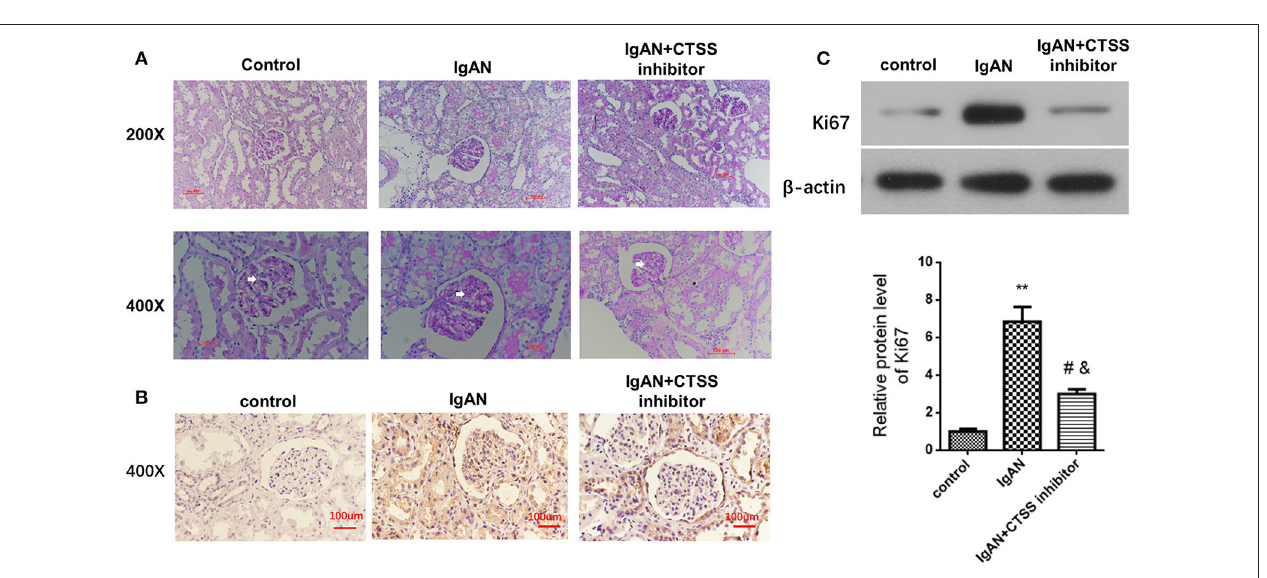
Frontiers in Pediatrics |